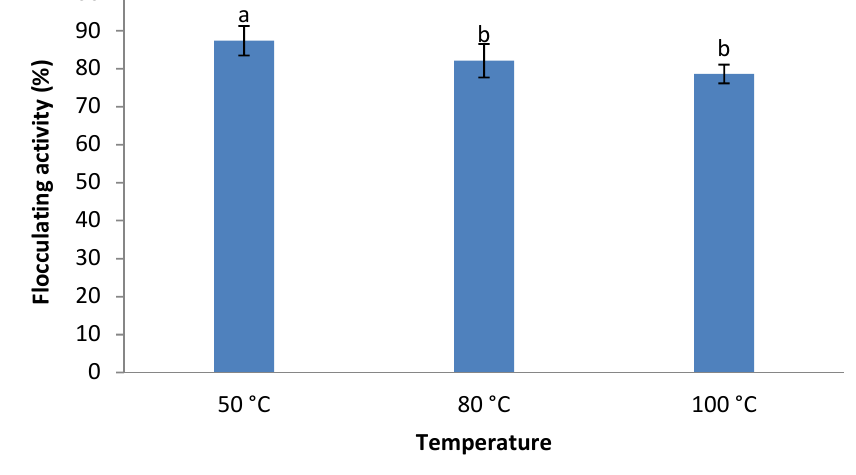
Figure 5. Effect of heat on the flocculating activity of the crude bioflocculant from Cobetia sp. OAUIFE. Flocculating activities with different letters are significantly different ( p < 0.05) from each other.